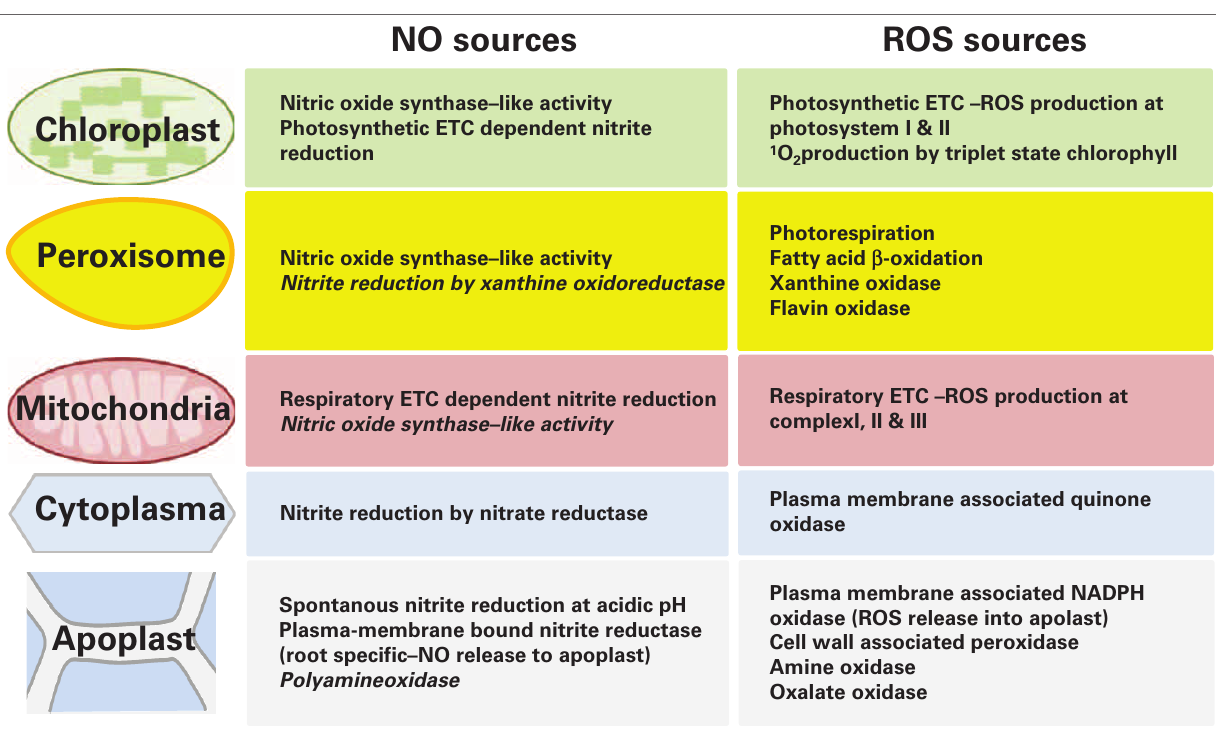
Table 2 | Localization of NO and ROS sources in plant